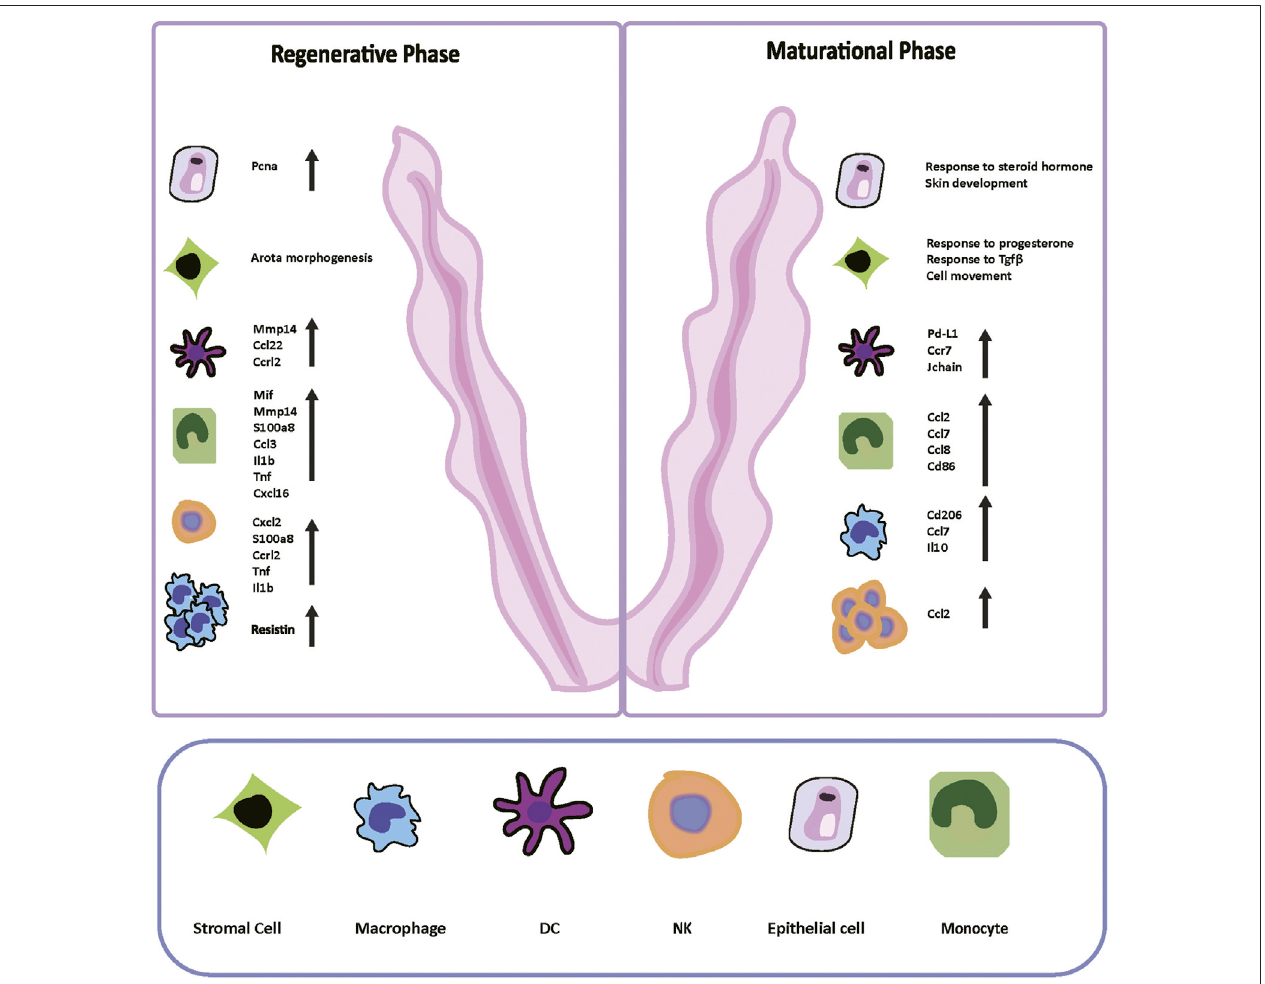
FIGURE 6 | Digital Cell Atlas of Mouse Uterus: from regenerative stage to maturational stage. Based on the Pcna expression, differentially expressed genes, and geneontologytermsoftwostages,webuiltupthecellatlasofthemouseuterusfromtheregenerativetomaturationalendometrium.Thenumberandfunctionofimmune cells varied sharply in two periods. In the regenerative stage, mice epithelial cells expressed Pcna highly, and the term “ aorta morphogenesis ” was enriched in stromal cells. Macrophages dominated in this stage. The immune system was boosted with intensely secreted cytokines and chemokines. In the maturational stage, cells presented more dynamic cell communication instead of proliferating. Terms “ response to progesterone and other steroid hormones ” and “ response to transforming growth factor beta ” were enriched. NK cells dominated in this stage. The immune responses were suppressed compared to the regenerative stage by reducing in fl ammatory cytokines secretion and facilitating differentiation into immune-suppressive cells. Pcna : proliferating cell nuclear antigen; NK: natural killer; DC: dendritic cells.